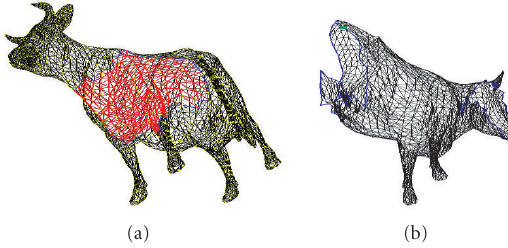
Figure 7: Combining our strategy with the valence driven algo- rithm on an irregular cow mesh, (a) the colored patch shows the neighborhood after 400 vertices are distributed to di ff erent pack- ets. (b) Shows the partly reconstructed mesh after 3000 vertices are retrieved from the packets.